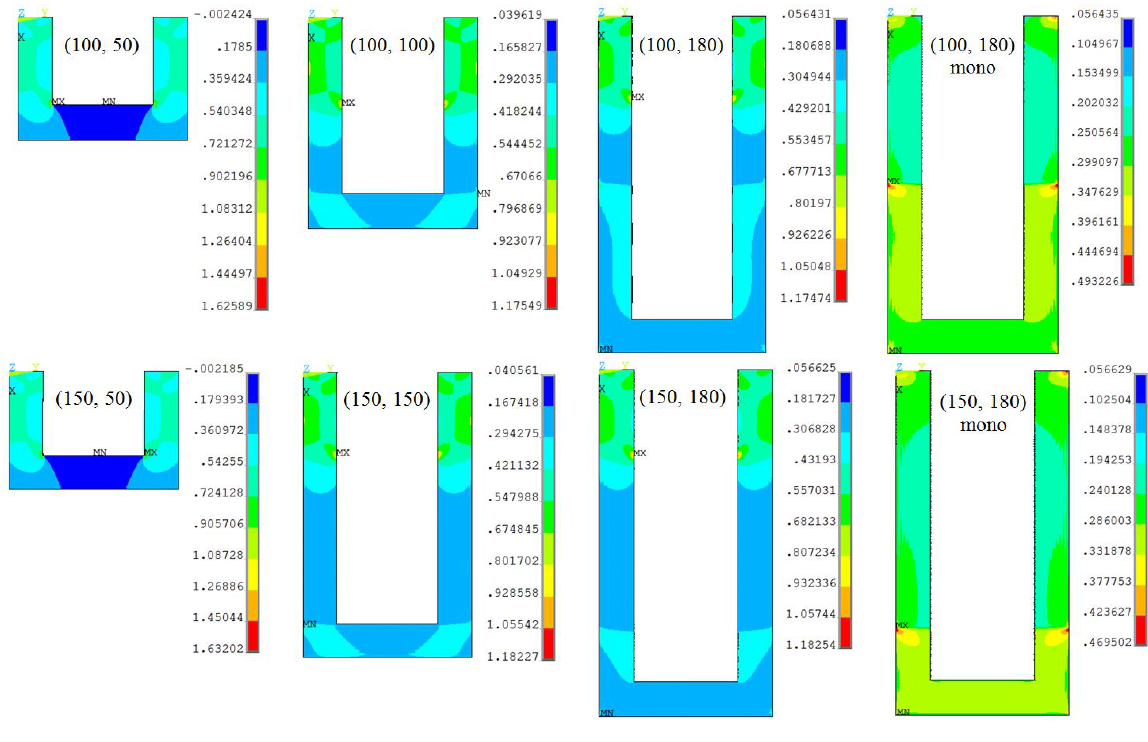
Figure 3. The longitudinal stress distribution (MPa) in different ( l , l for surface stress 0.04 N/m.